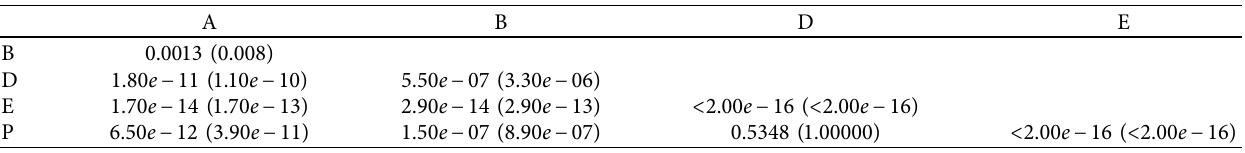
Table 13: In L-Space, for TransAntofagasta network, pI � 0.05, pR � 0.0025, and T � 65, p -value of the Wilcoxon rank sum test (resultant p -value per Bonferroni correction is indicated in brackets).